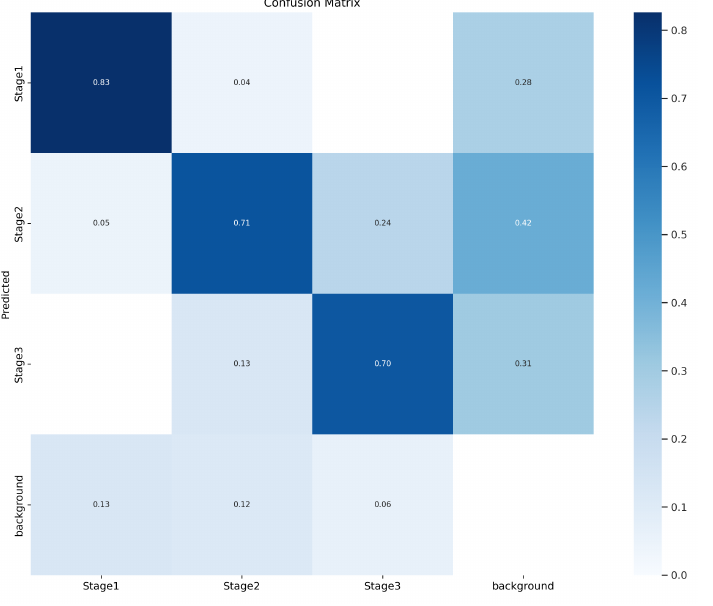
Figure 8. Confusion matrix for all mushroom growing